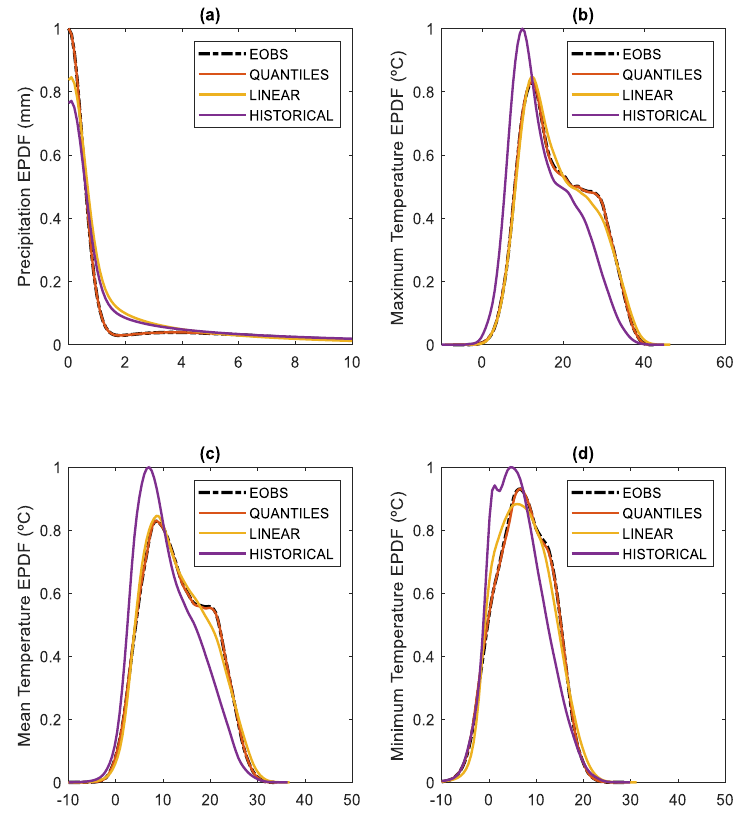
Figure 2. Empirical probability distribution functions (EPDF), with kernel-density estimation, for the historical period (1989–2005), for the daily ( a ) total precipitation, ( b ) maximum temperature, ( c ) mean temperature, and ( d ) minimum temperature, for E-OBS data (dashed black line), bias-corrected data using the quantile mapping (orange line) and linear (yellow line) methods, and the original model simulation data (no bias correction for the historical period; purple line).